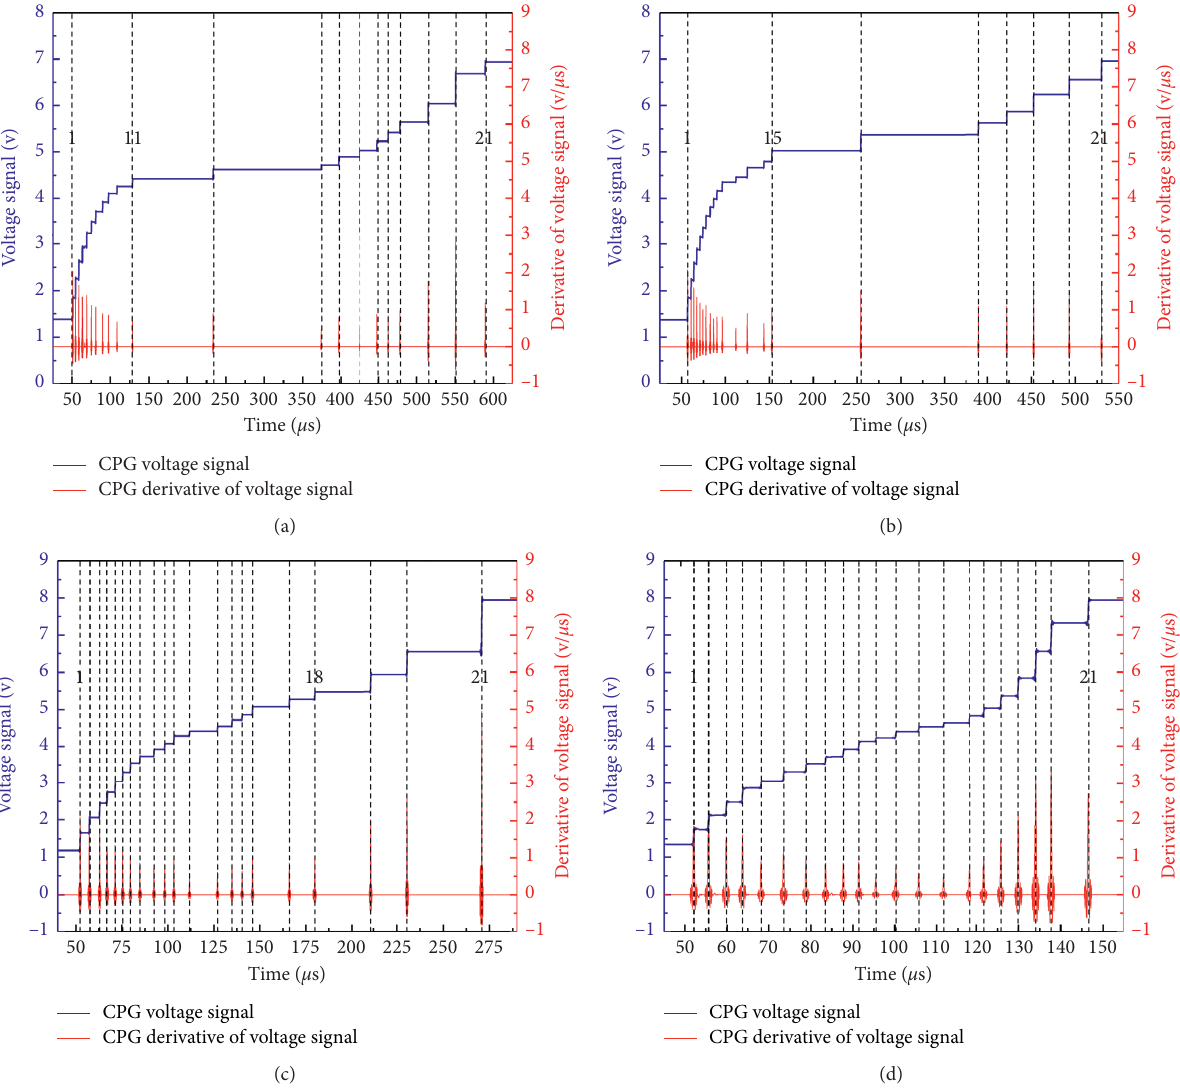
Figure 9: The voltage signal recorded by CPGs and its derivative. (a) S � 40mm. (b) S � 60mm. (c) S � 80mm. (d) No existing parallel